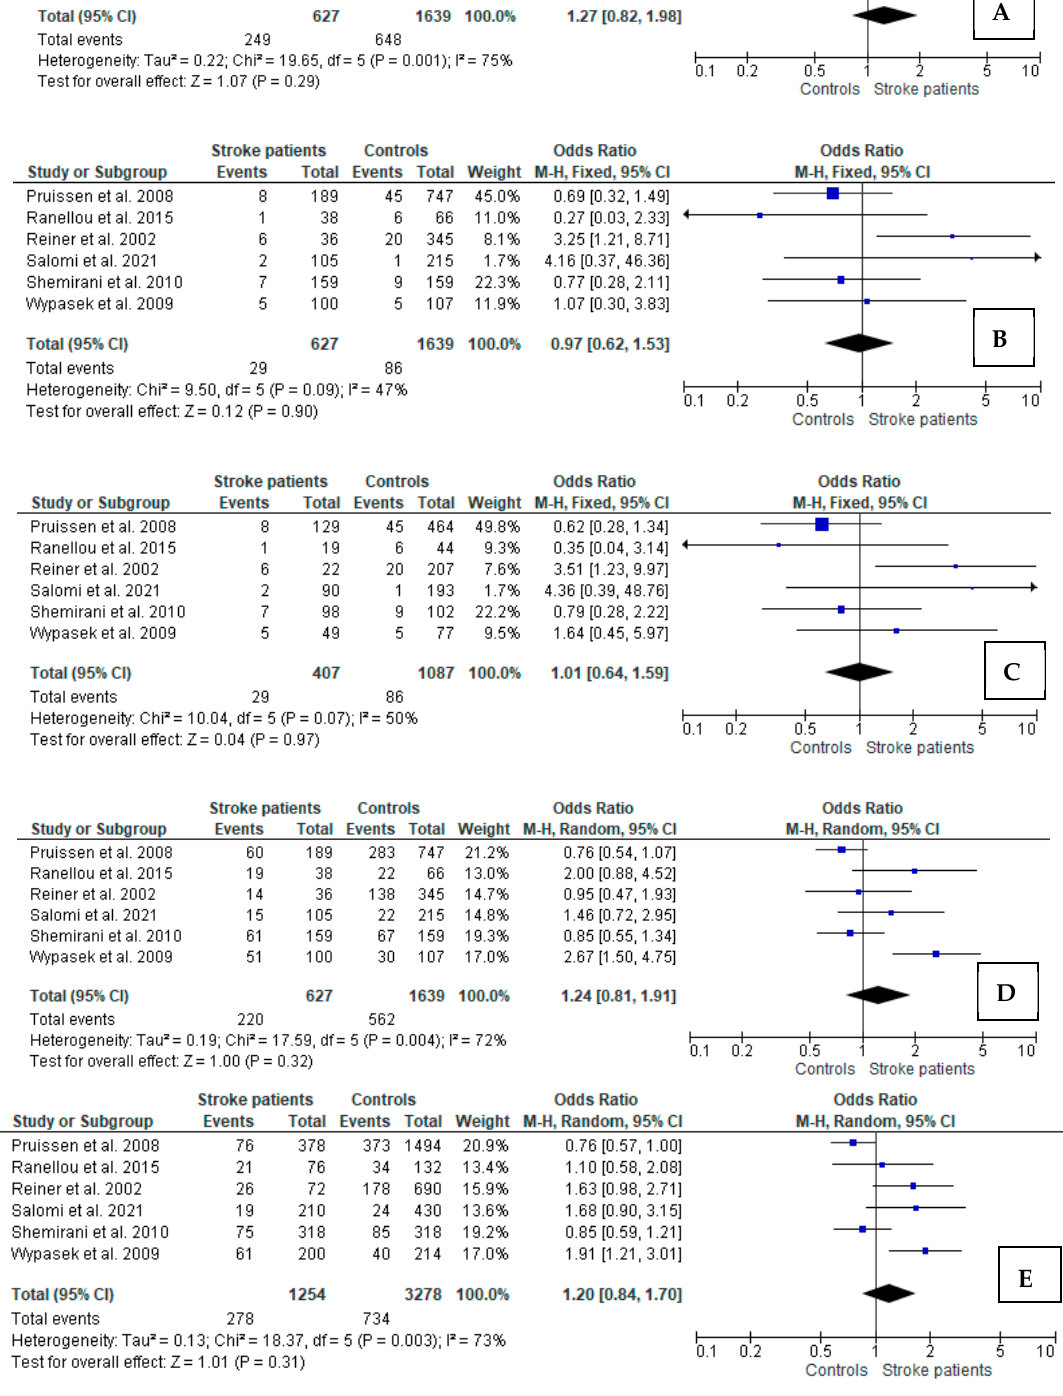
Figure 2. Forest plots for relations between different genetic models of FXIII polymorphism and ischemic stroke in total groups of young patients: ( A ) Val/Leu + Leu/Leu vs. Val/Val; ( B ) Leu/Leu vs. Val/Leu + Val/Val; ( C ) Leu/Leu vs. Val/Val; ( D ) Val/Leu vs. Val/Val; ( E ) Leu vs. Val. M-H: Mantel–Haenszel; CI: confidence interval; I 2 : heterogeneity; df: degrees of freedom [10–12,26–28] .